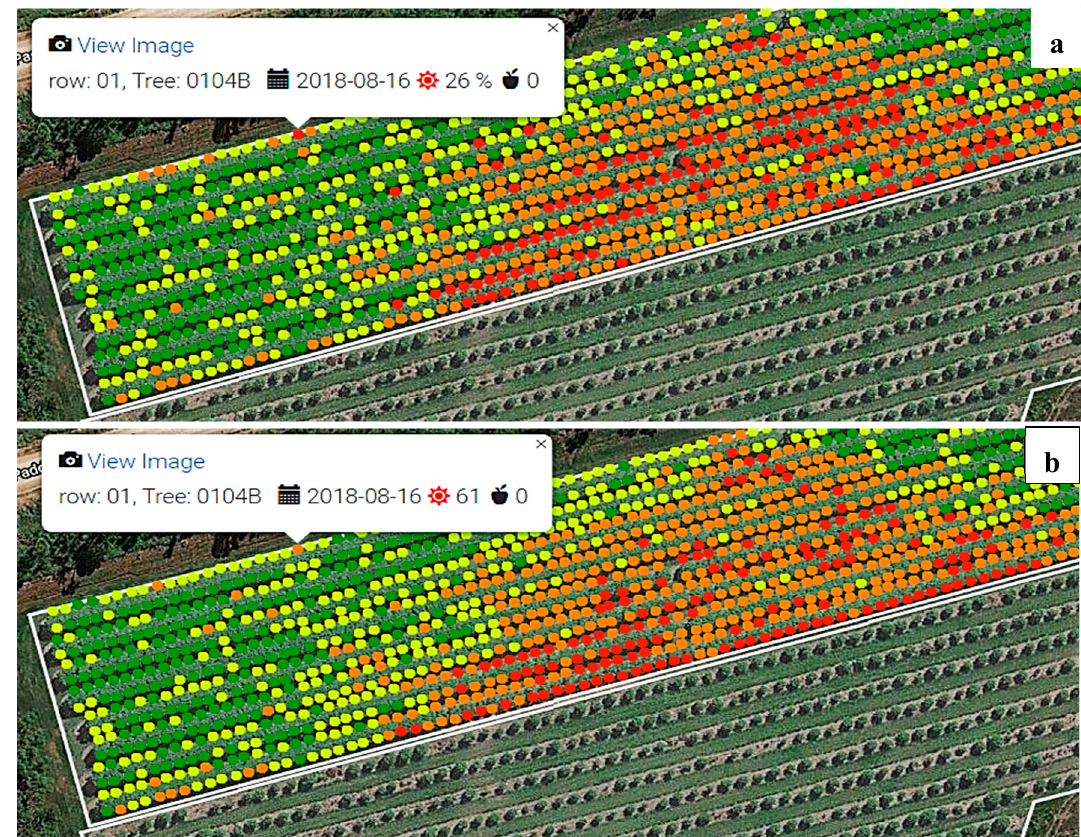
Figure 10. ( a ) Intensity level and ( b ) panicle count (using R 2 CNN(-rotated)) of an orchard with tree rows (994 trees, 1988 images). The colours green, orange and red colour corresponds to low, medium and high flowering levels, per tree with each coloured dot representing the image of one side of a tree. In the top panel the categories are in terms of flower pixels as a percentage of canopy pixels (<10%, 10% to 25% and >25%). In the bottom panel, the categories are in terms of total panicle number (<30, 30 to 70 and >70 panicles per tree image).